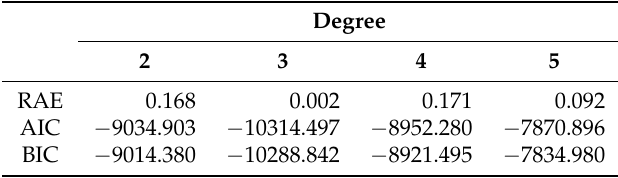
Table 5. Example 2. Measures for choosing the estimated